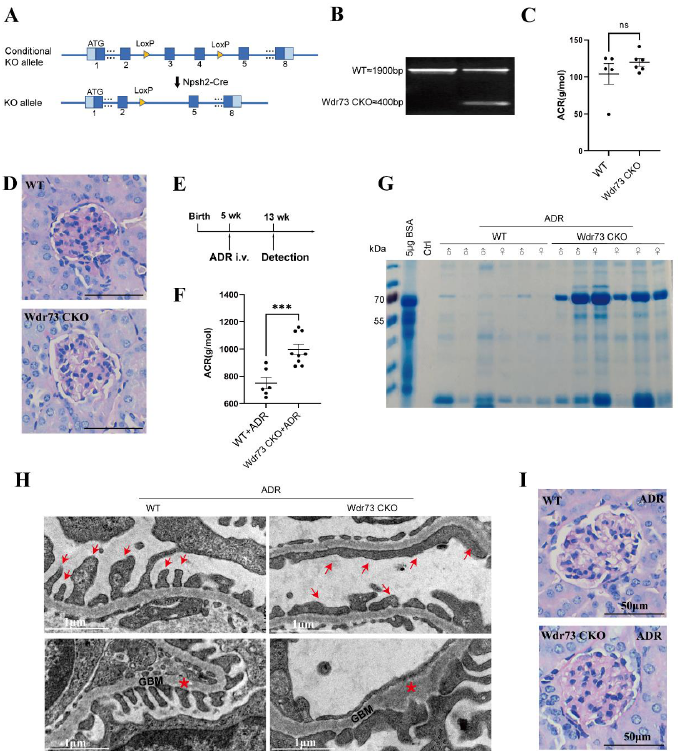
Figure 6. WDR73 was required for podocyte FP maintenance. ( A ) Schematic depicted generation of conditional knockout mice in which WDR73 is specifically ablated in podocytes by crossing Wdr73flox/flox with Nphs2Cre mice. ( B ) PCR genotyping of genomic DNA from the isolated glomeruli of Wdr73 CKO mice. Wild-type (upper band) and exon 3 and exon 4 deletion (lower band) alleles of the Wdr73 gene. ( C , D ) Loss of WDR73 did not result in an obvious renal phenotype, assessed by measurement of albuminuria and histologic analysis (PAS stain) up to an age of 20 weeks (each dot indicates an individual animals. ACR, albumin–creatinine ratio. Scale bars, 50 μm each. ( E ) Schematic depicting the timeline of the ADR nephropathy model in Wdr73 CKO mice. ( F , G ) Quantitation of urinary ACR and SDS–PAGE analysis showed increased levels of proteinuria in ADR-treated WT and Wdr73 CKO mice at 13 weeks (dots indicate individual animals), *** p < 0.001 ( t -test). ( H ) Representative TEM images of glomeruli in ADR-treated WT and Wdr73 CKO mice at 13 weeks. Compared with WT mice, Wdr73 CKO mice exhibited increasing GBM (red asterisks) and pronounced widening and effacement of podocyte FPs (red arrows). Scale bars, 1 μm each. ( I ) PAS- stained kidney sections of ADR-treated WT and Wdr73 CKO mice at 13 weeks. Scale bars, 50 μm